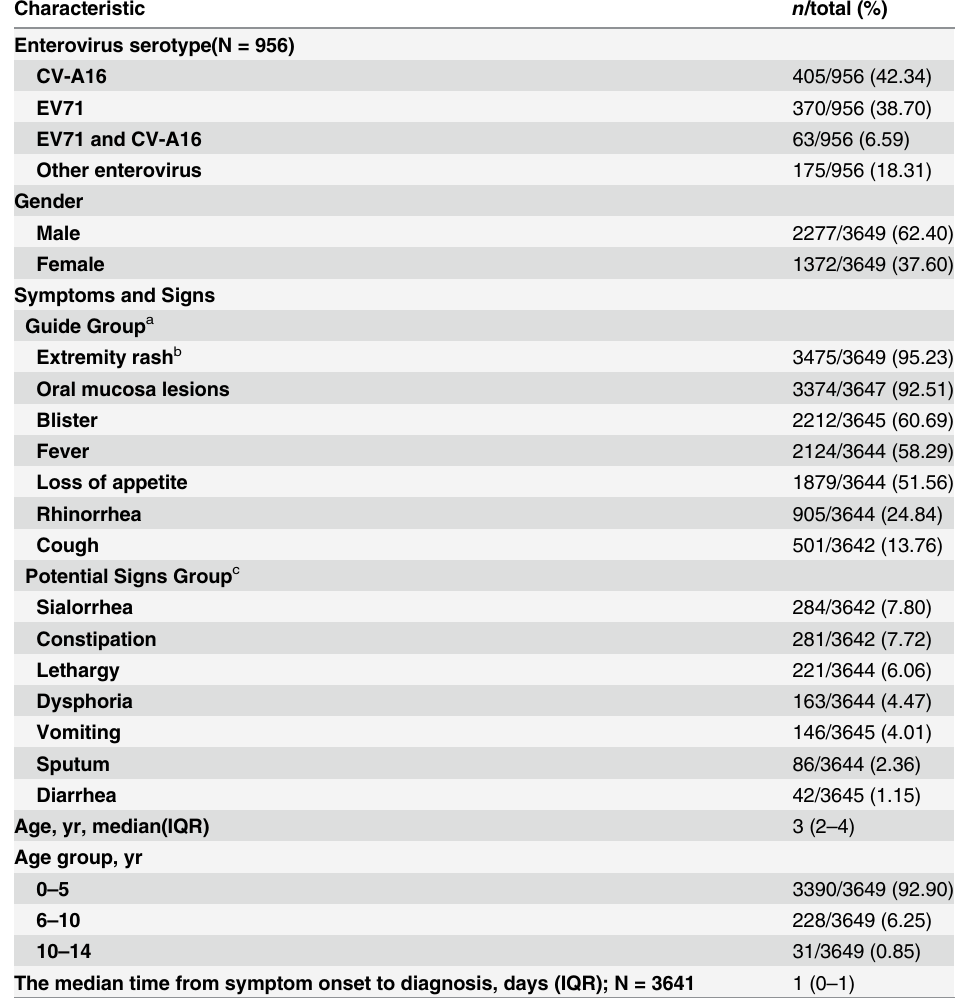
Table 1. Characteristics of probable and laboratory-confirmed cases of mild